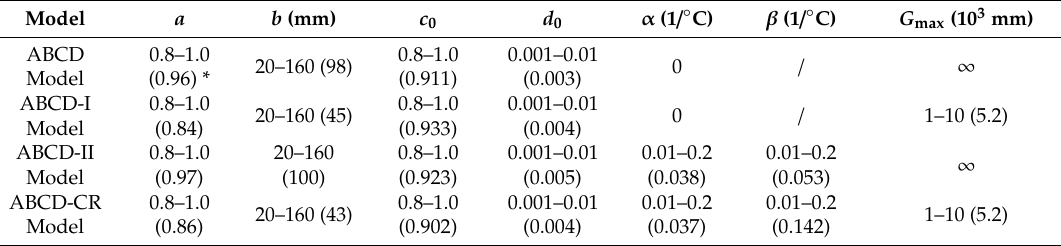
Table 2. Presumed parameter ranges for model calibration and optimal